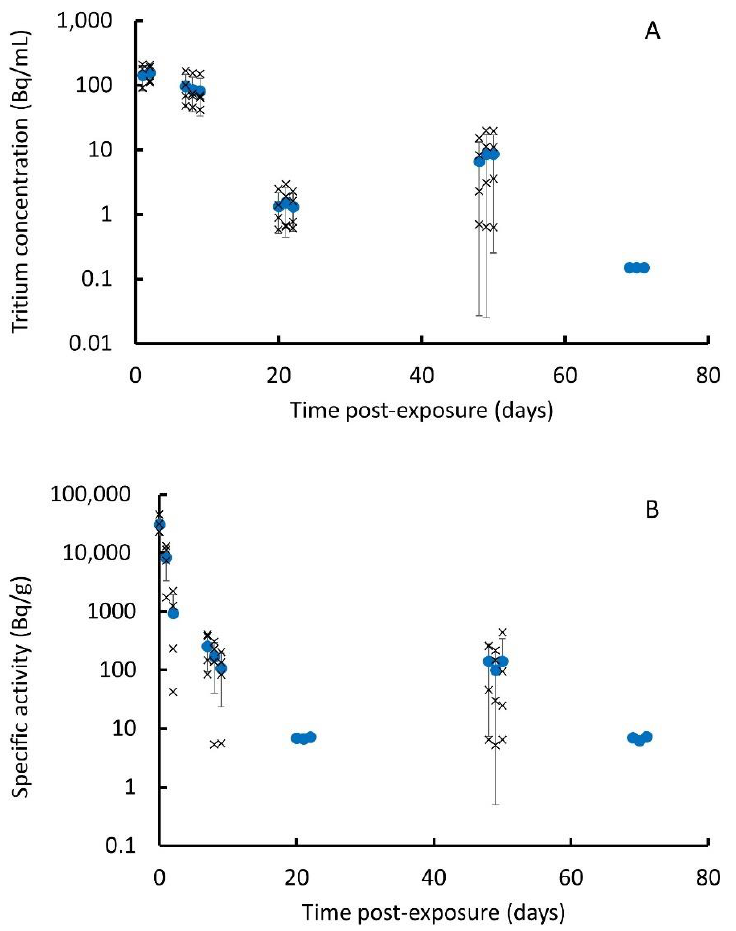
Figure 4. Tritium excretion: ( A ) tritium concentration of urine samples; and ( B ) specific activity of faecal samples (crosses are values for single animals, solid circles and error bars are mean ( n = 4) ± SD. Note that values without error bars are at limit of detection and are included for indicative purposes only).